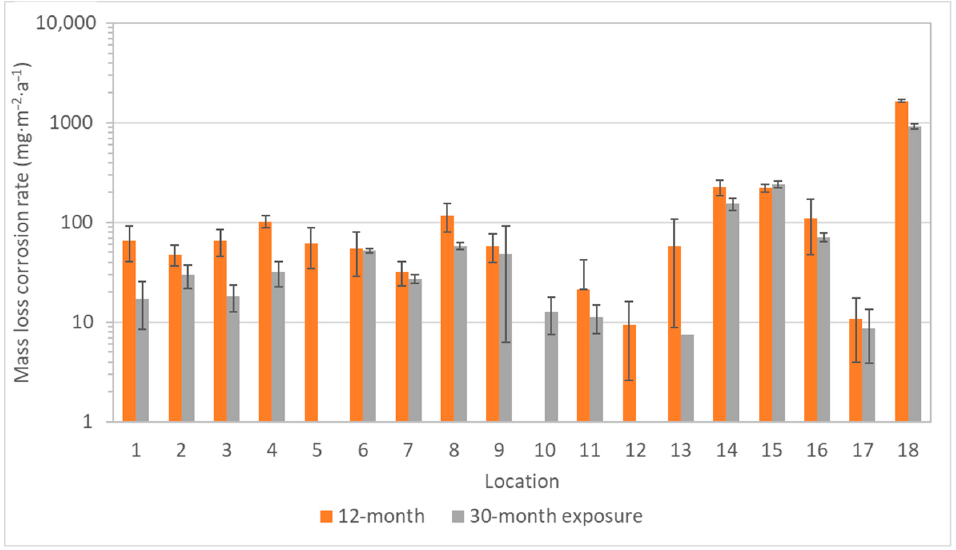
Figure 13. Corrosion rate calculated from mass loss of zinc coupons (logarithmic y -axis scale, 3-month exposure of zinc coupons did not take place).